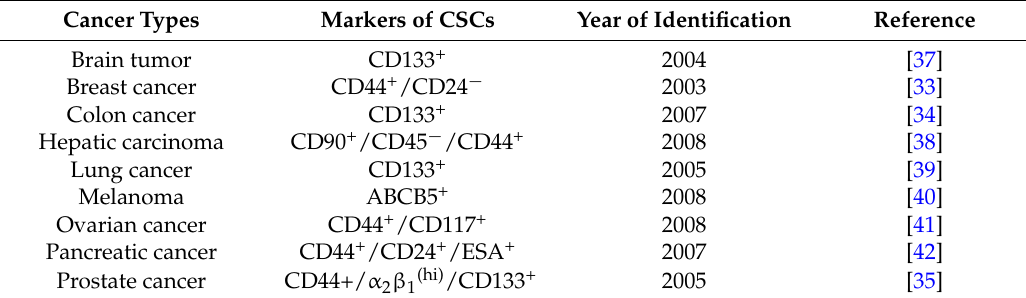
Table 1. Cancer stem cell (CSC) in solid tumors and their first isolation